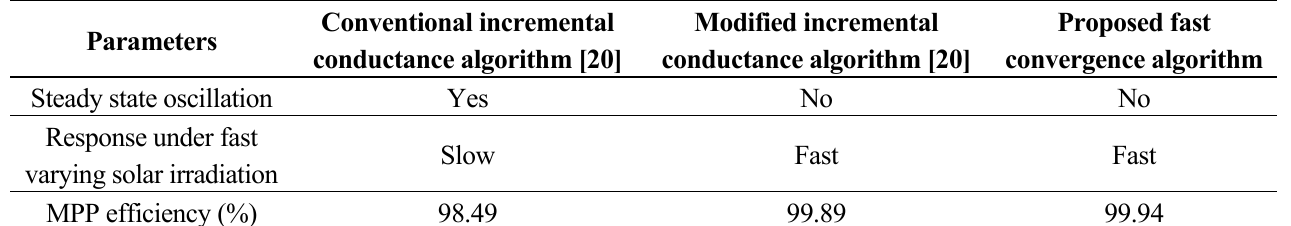
Table 1. Comparison of the proposed algorithm with the conventional incremental conductance and modified incremental conductance